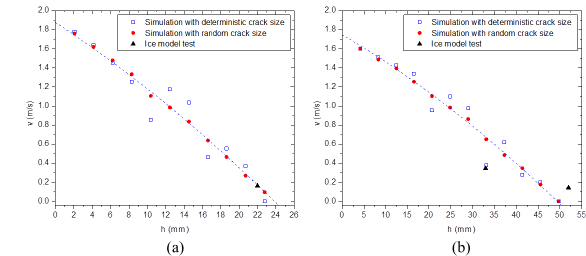
Figure 16: (a) h − ν curve obtained when the vessel is running ahead. (b) h − ν curve obtained when the vessel is running astern. All num- bers are at model scale, and simulations are conducted with deterministic and random crack